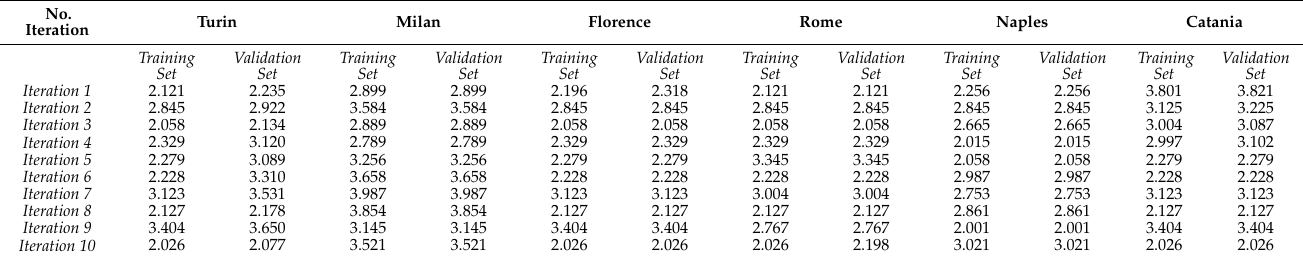
Table 4. Average percentage errors (%) obtained through a ten-fold cross-validation.